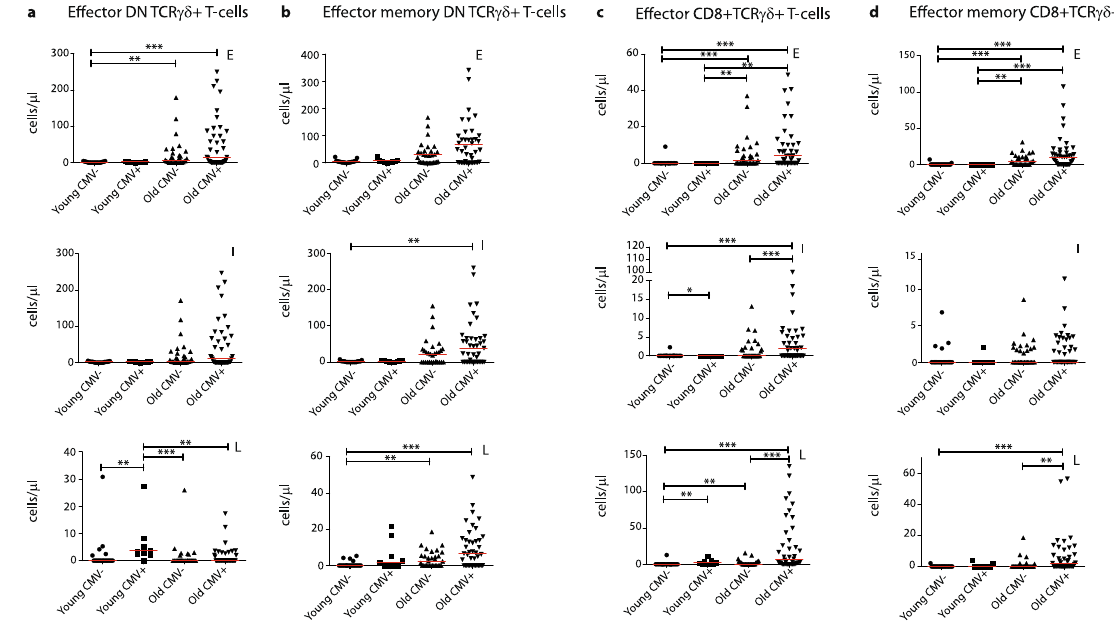
Figure 7. Effect of CMV on effector and effector memory differentiation stages. ( a ) Absolute numbers of early (CD27 + CD28 + ), intermediate (CD27 + CD28 − ) and late (CD27 − CD28 − ) differentiated DN and ( c ) CD8 + TCR γδ+ effector (CD45RO − CD197 − , Temra) T-cells. ( b ) Absolute numbers of early, intermediate and late differentiated DN and ( d ) CD8 + TCR γδ+ effector memory (CD45RO + CD197 − , Temro) T-cells. Early (E), intermediate (I) and late (L) definitions are indicated in the upper right corners of the graphs. Scatter plots are indicated with the median. Significance was tested by a Kruskal-Wallis test, followed by a post-Dunn’s test for correction for multiple testing. Significance for the Dunn’s test is indicated in the plots: ** p < 0.01; *** p <